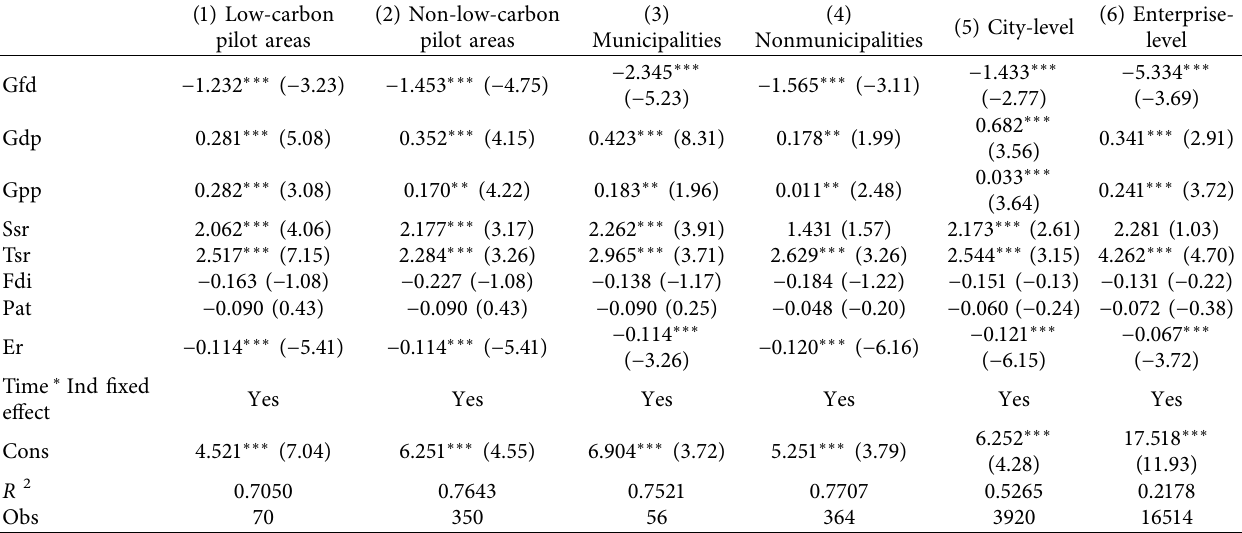
Table 3: Robustness test.